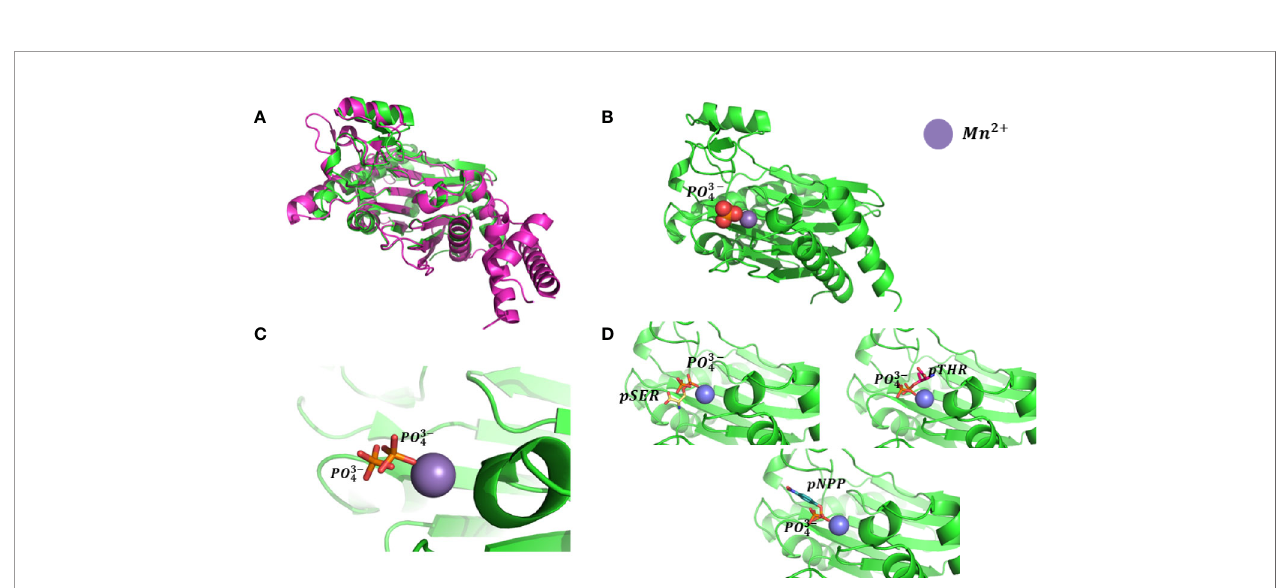
FIGURE 3 | Testing of docking model. (A) Superposition of human PP2Ca structure (shown as magenta cartoons, PDB: 4RA2) and plant group A PP2C (shown as green cartoons, PDB: 3KDJ); (B) Monophosphate ion binding pose. Ions shown as spheres; the position of the monophosphate ion was taken from the superposition of those two phosphatase structures; (C) Redocking pose of the monophosphate ion using our proposed binding model and comparison with position of the monophosphate ion present in mammalian phosphatase PP2Ca; (D) Docking pose of pSER, pTHR, and pNPP. Docked molecules are shown as stick